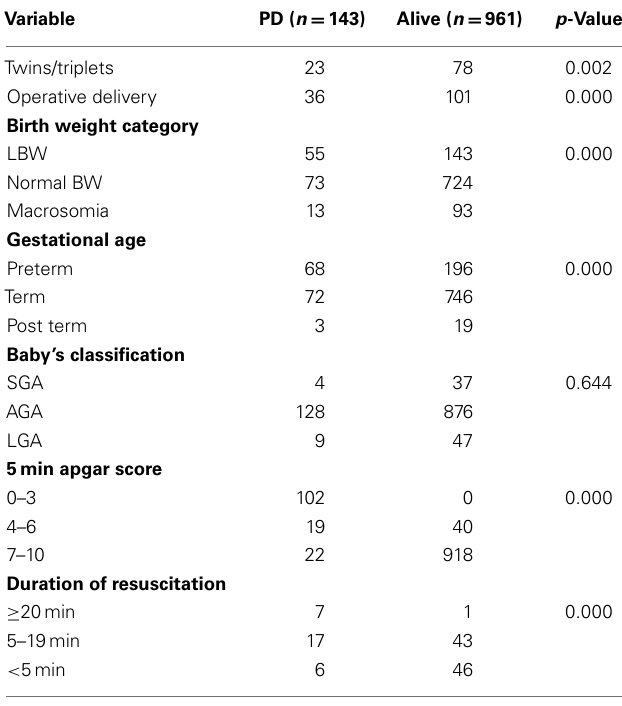
Table 6 | Neonatal characteristics association with perinatal deaths .